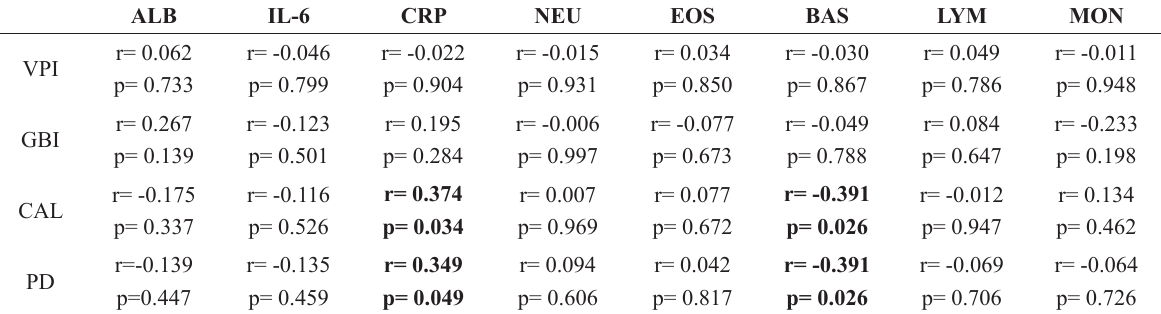
Correlation of variables changes (Δ) between periodontal outcomes and serum biomarkers after periodontal therapy in the CP